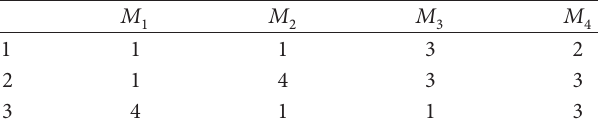
Table 1: Data of a 3-job-4-machine flowshop